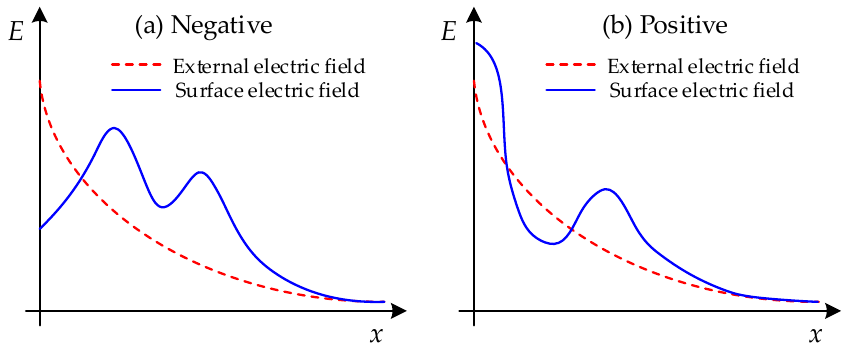
Figure 16. Electric field distribution at a high pressure with different polarities.